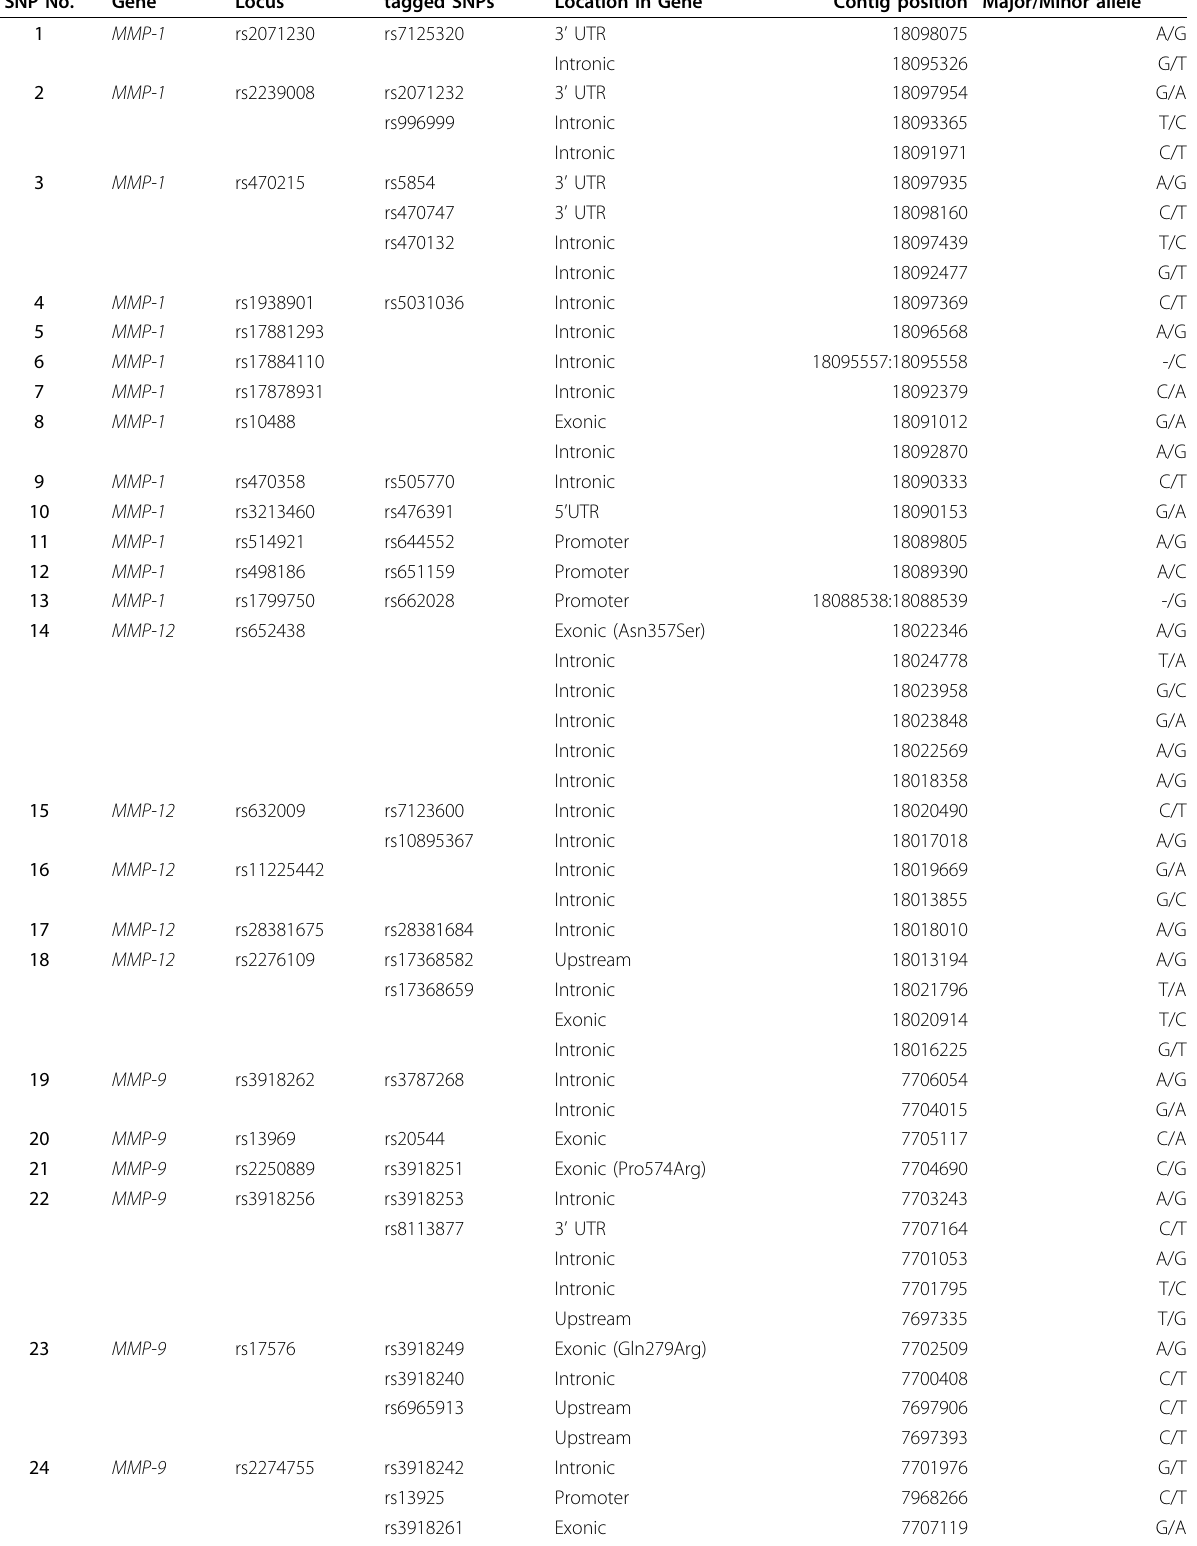
Table 4 SNPs selected for genotyping SNP